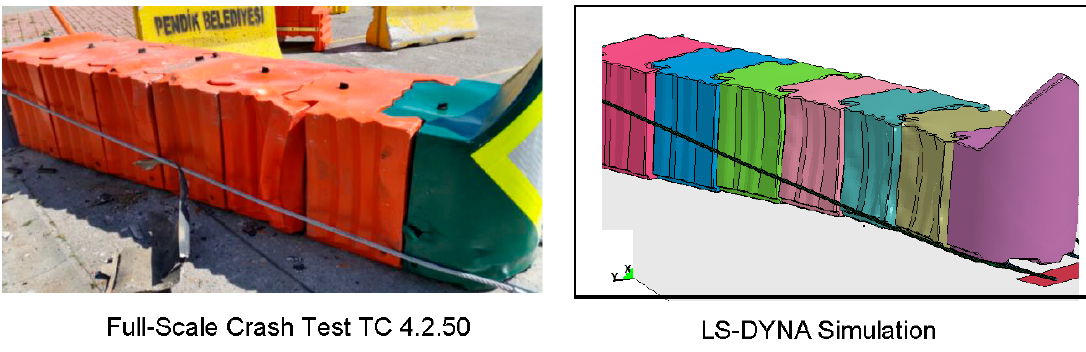
Figure 11. Deformed shape comparison of UCC after TC 4.2.50 crash test and simulation.